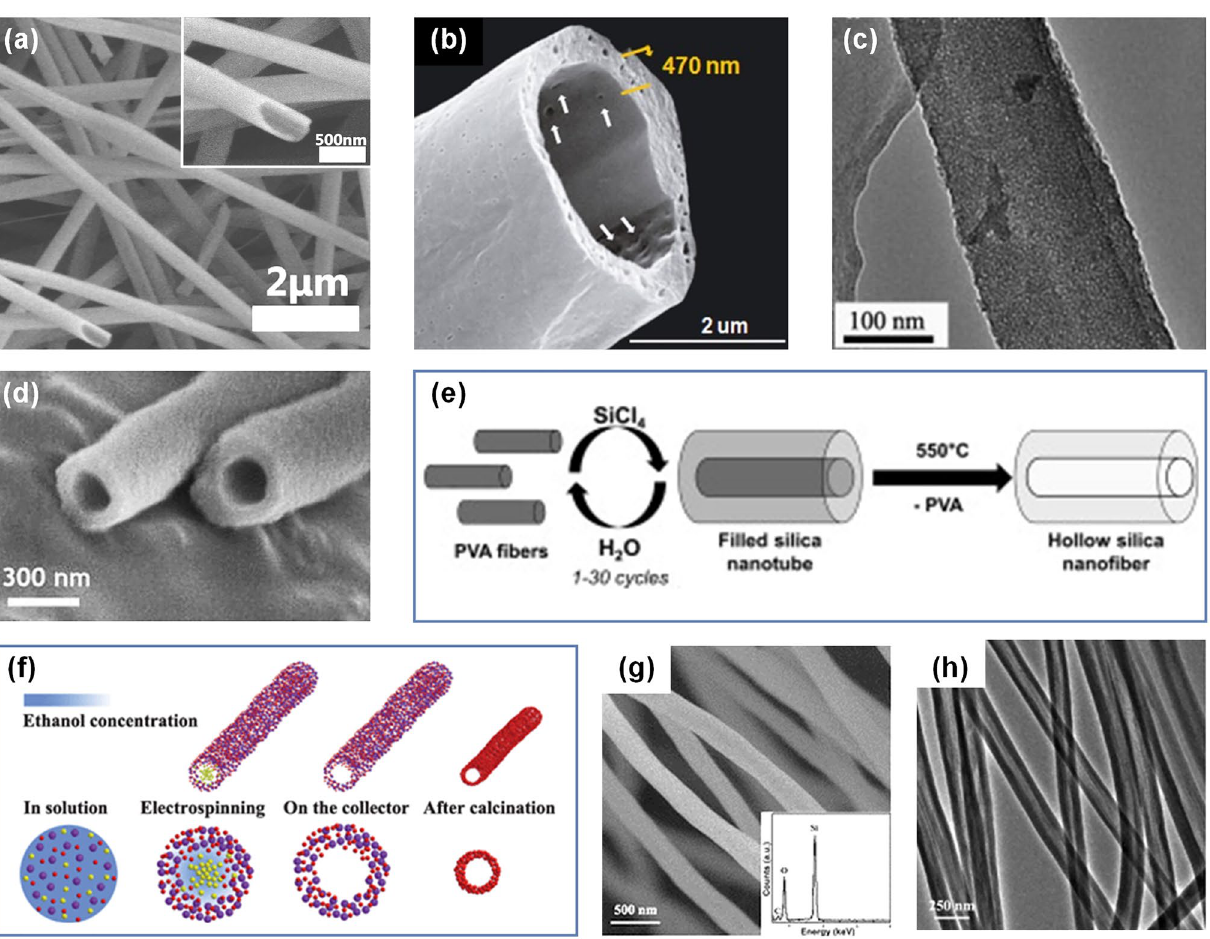
Fig. 4 a SEM image of hollow SNFs. The inset is the corresponding high magnified SEM image [93]. Copyright 2017, Elsevier. b SEM image of hollow SNFs after calcination [94]. Copyright 2011, The American Ceramic Society. c High‑resolution TEM of hollow SNFs [95]. Copy‑ right 2007, Elsevier. d Magnified SEM image of hollow SNFs [36]. Copyright 2009, to the authors (Ming Zhou et al.). e Schematic illustration of preparation of hollow SNFs [96]. Copyright 2013, Elsevier. f Schematic diagram of the formation mechanism of hollow SNFs [98]. g SEM image of hollow SNFs after calcination. The inset is corresponding energy dispersive X‑ray spectrum [98]. h TEM image of hollow SNFs after calcination [98]. Copyright 2010, The Royal Society of